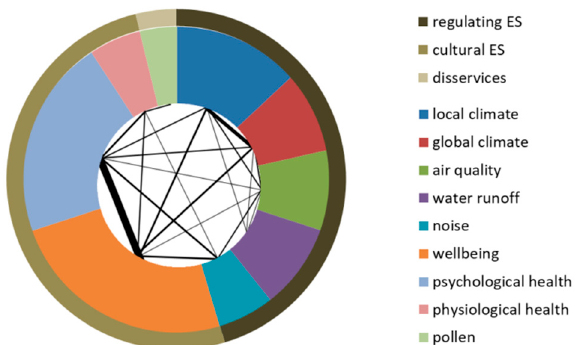
Figure 3. Distribution of articles by ES (outer circle) and topic (inner circle). The spider links topics addressed simultaneously, while the line thickness is proportional to the number of articles. The complete list of papers reviewed is given in Table A3.